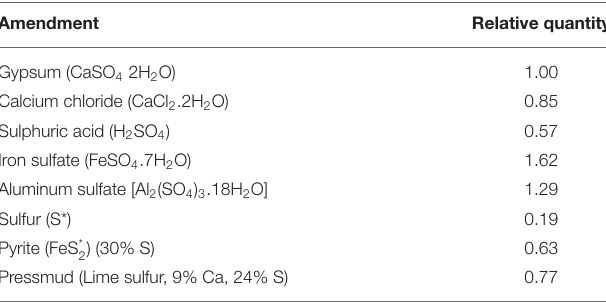
TABLE 4 | Equivalent quantities of some common amendments for sodic soil